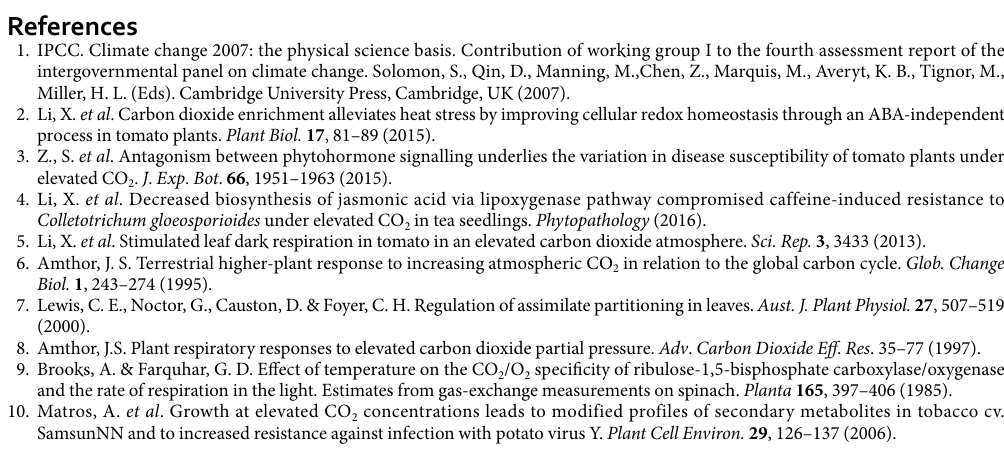
consisted of denaturation at 95 °C for 3 min, followed by 40 cycles of denaturation at 95 °C for 30 s, annealing at 58 °C for 30 s and extension at 72 °C for 30 s. Transcript abundance was normalized to actin , and relative gene expression was calculated following formulae of Livak and Schmittgen 43 . Four biological replicates were used for qPCR